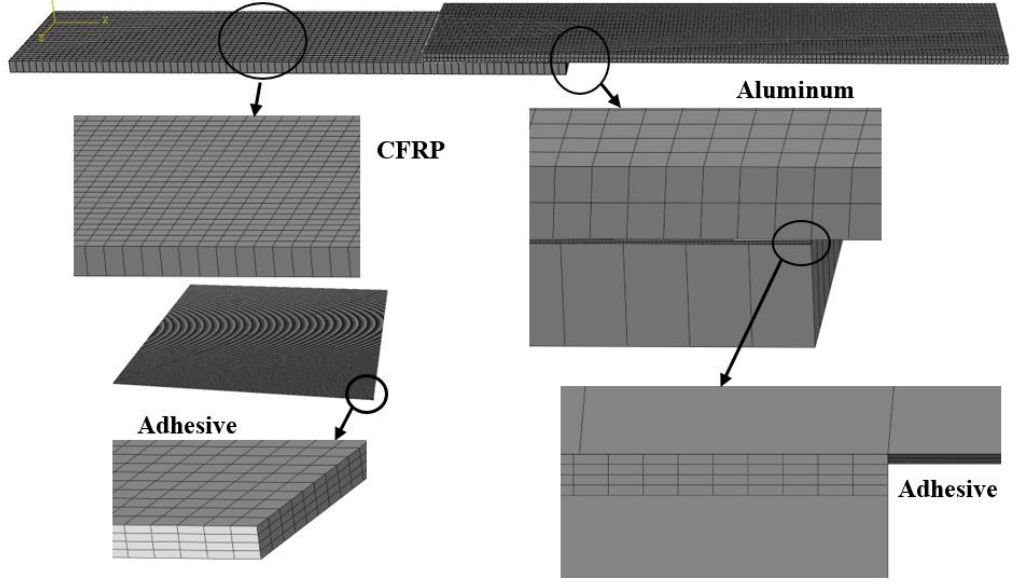
Figure 3. Mesh adapted for single-lap joint model.